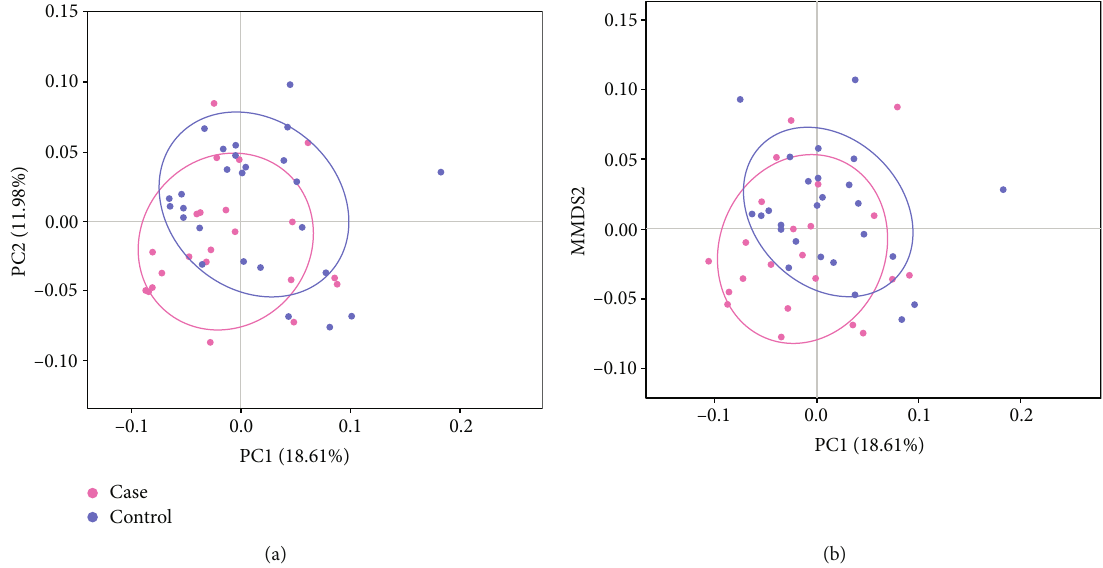
Figure 3: Analysis of beta diversity based on PCoA (a) and NMDS (b) with weighted UniFrac distance. MCI cases and control subjects are denoted with pink and blue nodes,